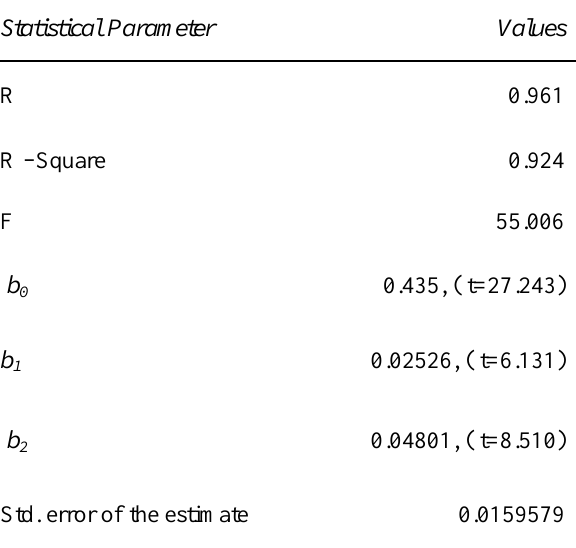
Table 5: Values of Statistical parameters Statistical Parameter